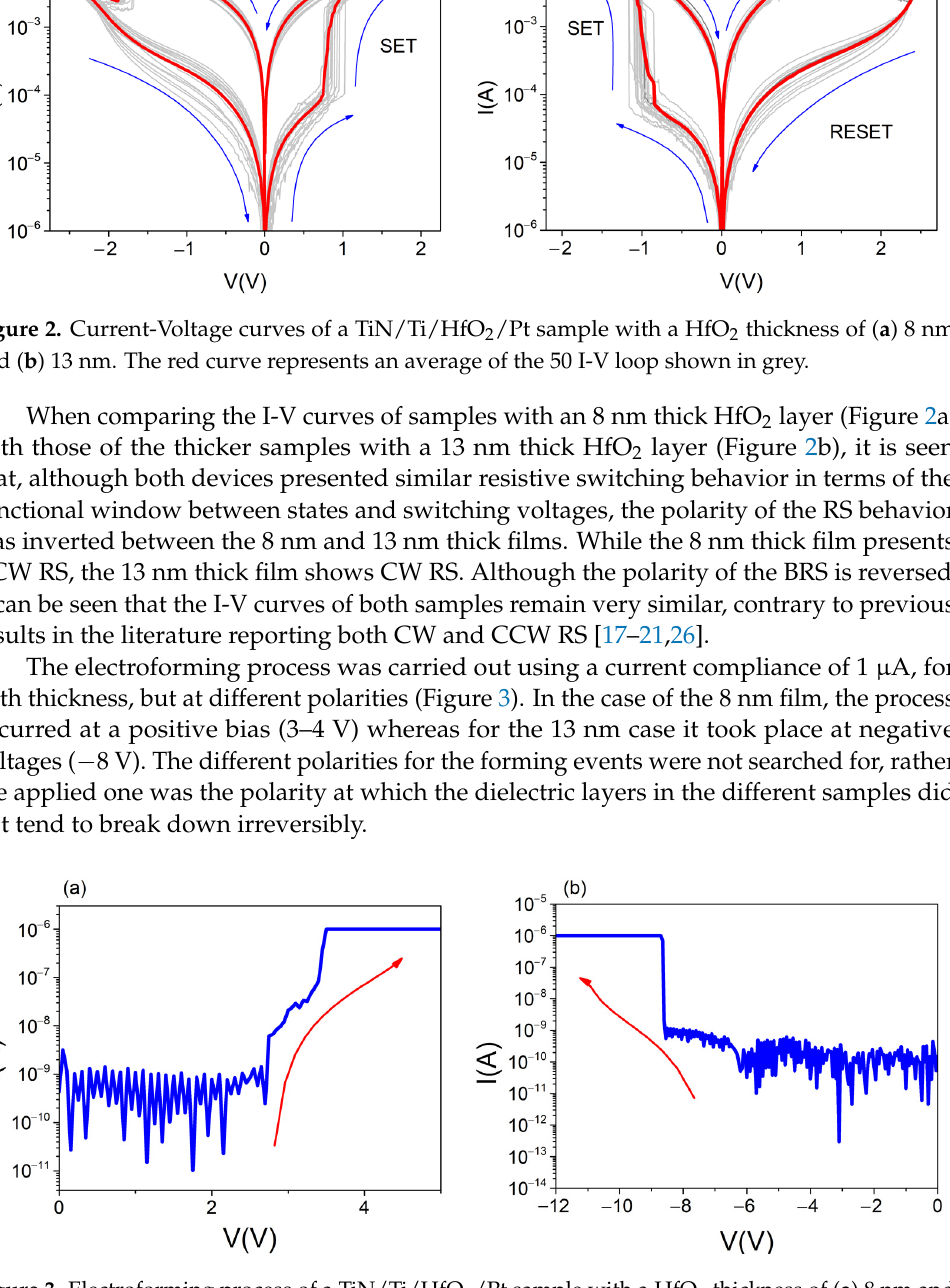
Figure 3. Electroforming process of a TiN/Ti/HfO 2 /Pt sample with a HfO 2 thickness of ( a ) 8 nm and ( b ) 13 nm.